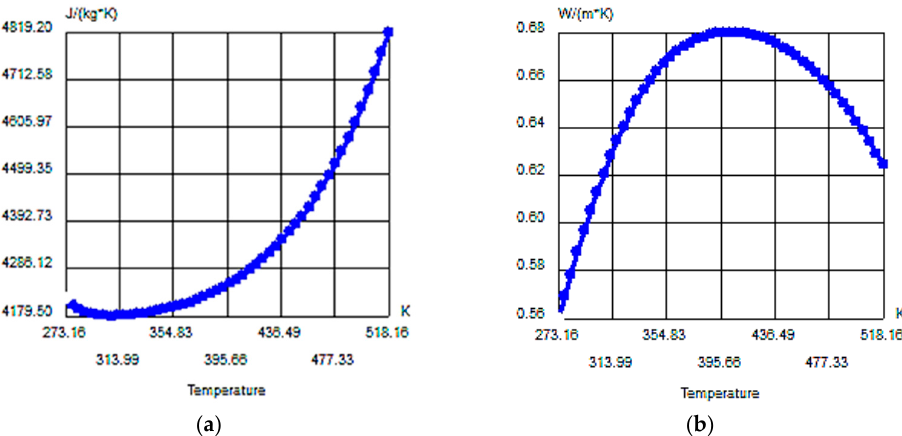
Figure 10. The variation curves of specific heat ( C p ) ( a ) and thermal conductivity ( λ ) ( b ) of pure water depending on the temperature used in the CFD calculations.